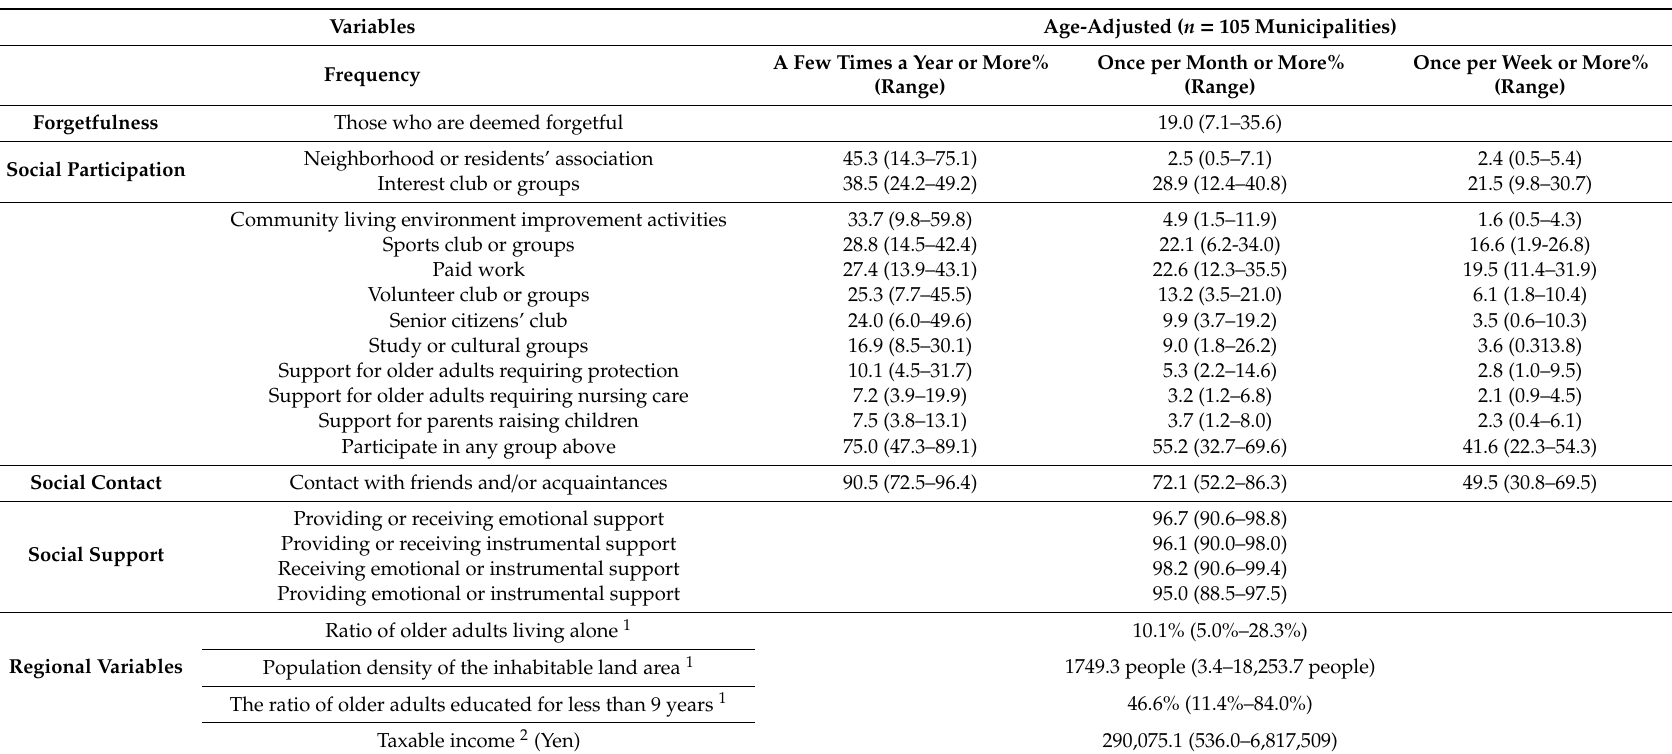
Table 1. Variables used in the analysis and means and ranges of ratios by